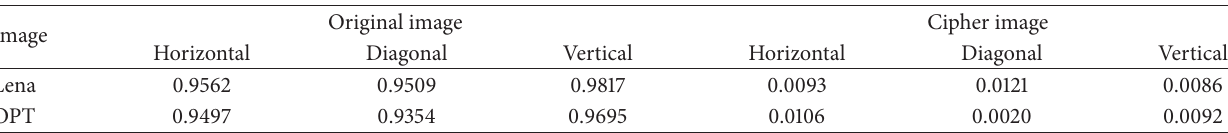
Original image Cipher image Image Horizontal Diagonal Vertical